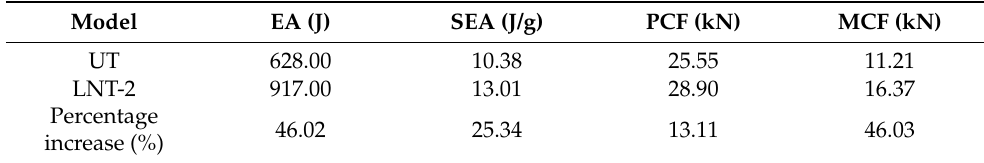
Figure 5. Load – displacement relation of UT and LNT-2. Figure 5. Load–displacement relation of UT and LNT-2. Table 3. Energy absorption parameters of empty tubes. Table 3. Energy absorption parameters of empty